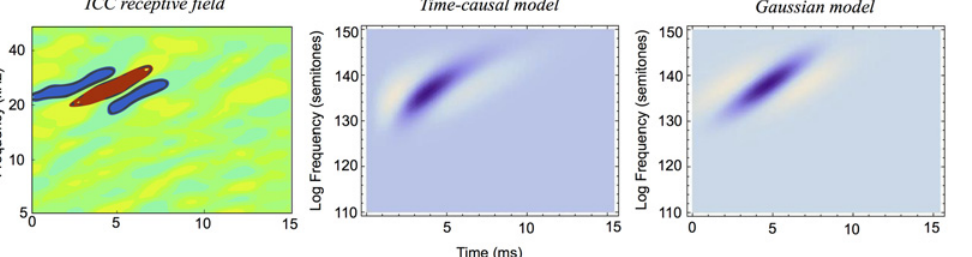
Fig 17. (left) A non-separable spectro-temporal receptive fields in the inferior colliculus (ICC) of Mexican free-tailed bat as reported by Andoni et al. [38] (schematic simplification only, see fig. 6(c) in [38] or fig. 18 in [64] for the original data). (middle and right) Second-order temporal derivative of idealized glissando-adapted receptive fields models (90) centered at semitone ν = 138, temporal scale σ t = 2 ms, logspectral scale σ ν = 3 semitones and glissando v = 1.5 semitones/ms for both models and additionally temporal delay δ = 4.7 ms for the Gaussian model.